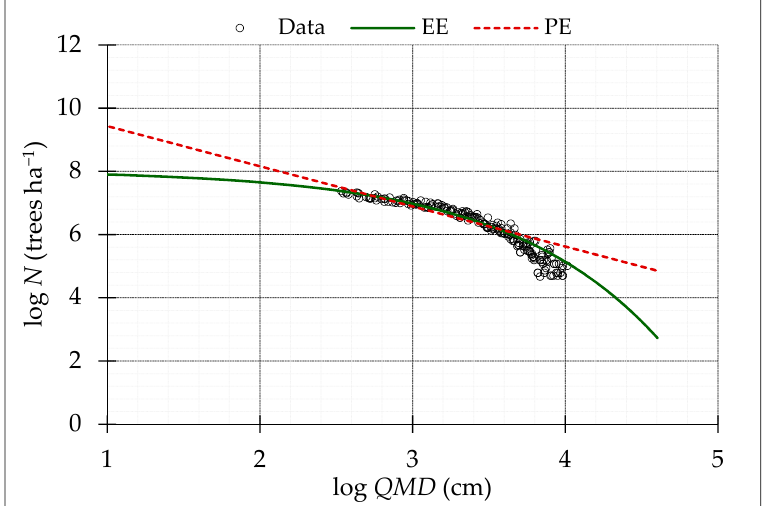
Figure 2. Maximum density lines (on log–log scale graphic) fitted for all species combined of the mixed-species plots. EE = the exponential equations (Equation (1)); PE = potential equations (Equation (6)).